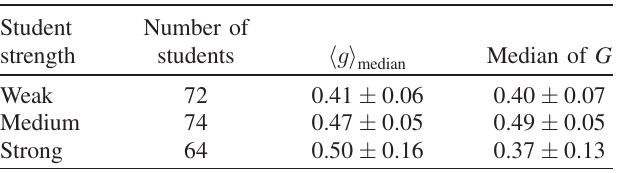
TABLE III. Median normalized gains for different student strengths in mixed